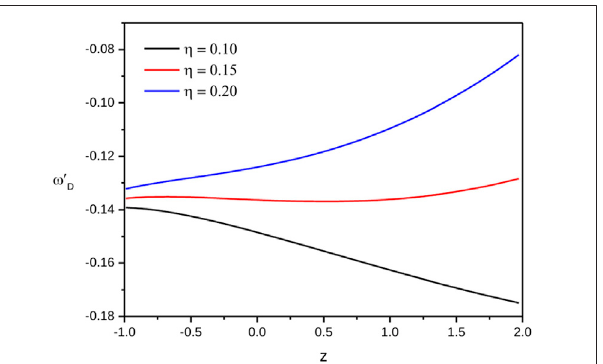
FIGURE 6 | Plot of ω D ′ of ghost dark energy f ( Q ) gravity model versus redshift for the appropriate choice of constants.